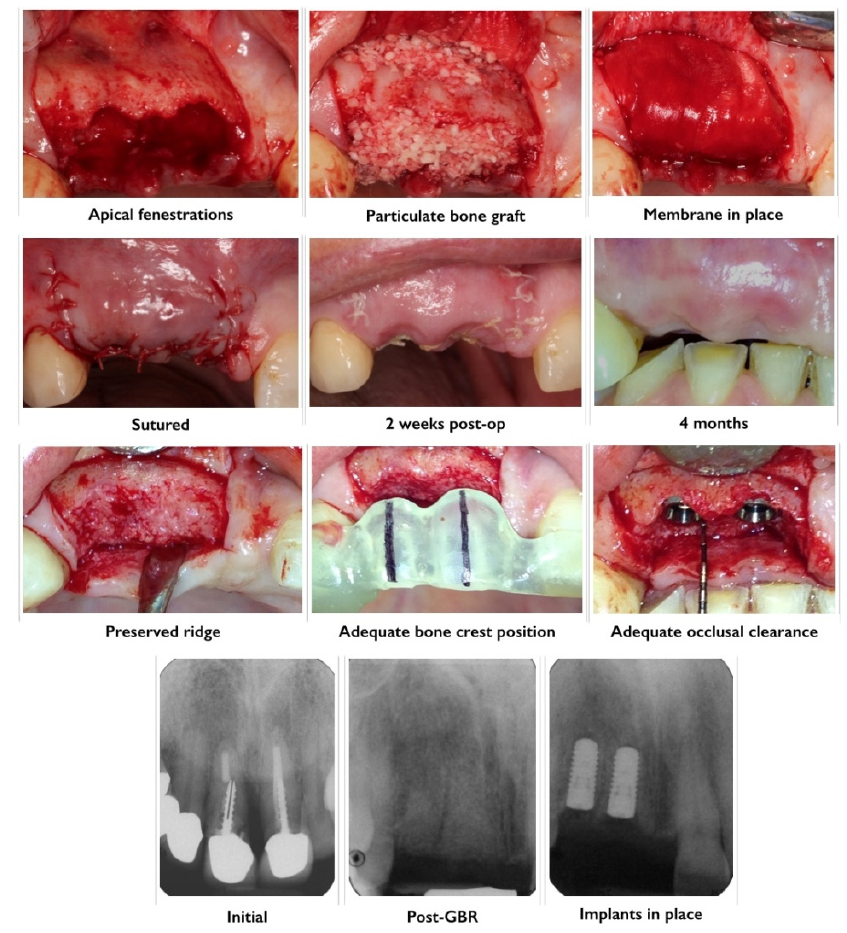
Figure 4. Alveolar bone preservation using a particulate allograft material. Exodontia of teeth 1.1 and 1.2 (failed endodontic treatments, post fracture, loss of clinical attachment) was performed and full thickness buccal and palatal flaps were raised. Post-extraction sockets were generously irrigated with saline and inspected for integrity of bony walls. Apical fenestrations of the buccal wall were detected at 1.1 and 1.2 sites. Irrigated particulate freeze dried bone allograft ( FDBA) was gently packed into sockets and covered with a double-layered porcine collagen membrane. Post-guided bone regeneration (GBR) healing